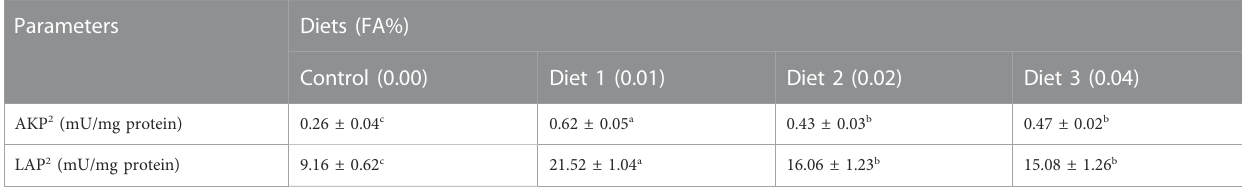
TABLE 6 Effects of supplemental fulvic acid on activities of digestive enzymes of large yellow croaker larvae (Means ± S.E.M, n = 3) 1 .